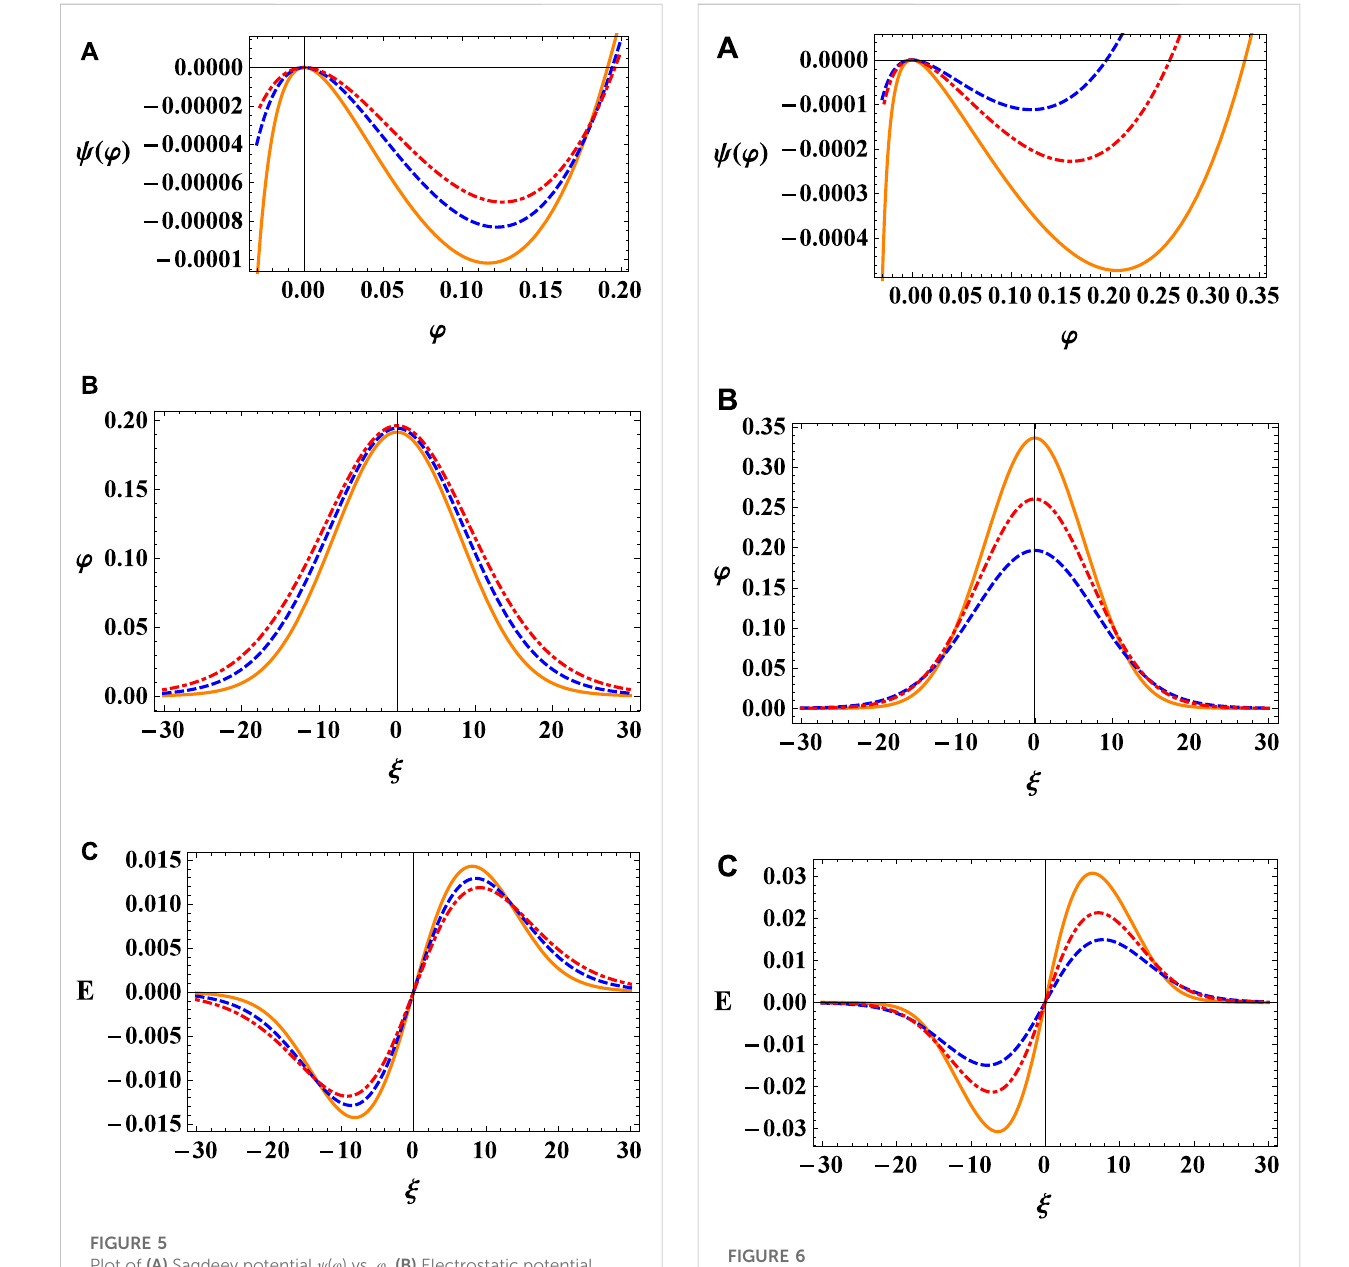
FIGURE 5 Plot of (A) Sagdeev potential ψ ( φ ) vs. φ , (B) Electrostatic potential φ and (C) Electric fi eld E fordifferentvaluesof p ⊥ =0.1(solidcurve),0.5 (dashed curve) and 0.9 (dot-dashed curve) with M = 0.9, Ω = 0.3, γ = 0.2, p (cid:3) = 0.2, α = 0.80, and σ = 0.1.